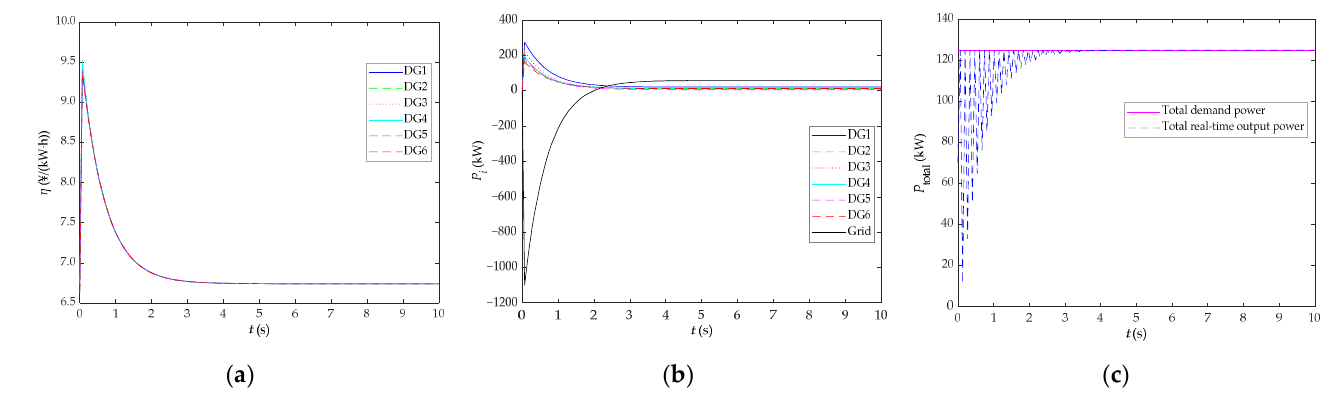
Figure 17. The change curves of variables of the system when ε is increased by 10 times: ( a ) change curves of each DG’s ICR; ( b ) change curves of each DG’s active output and grid output power; ( c ) change curves of the cumulative sum of each DG’s active output and grid output power as well as total demand power.